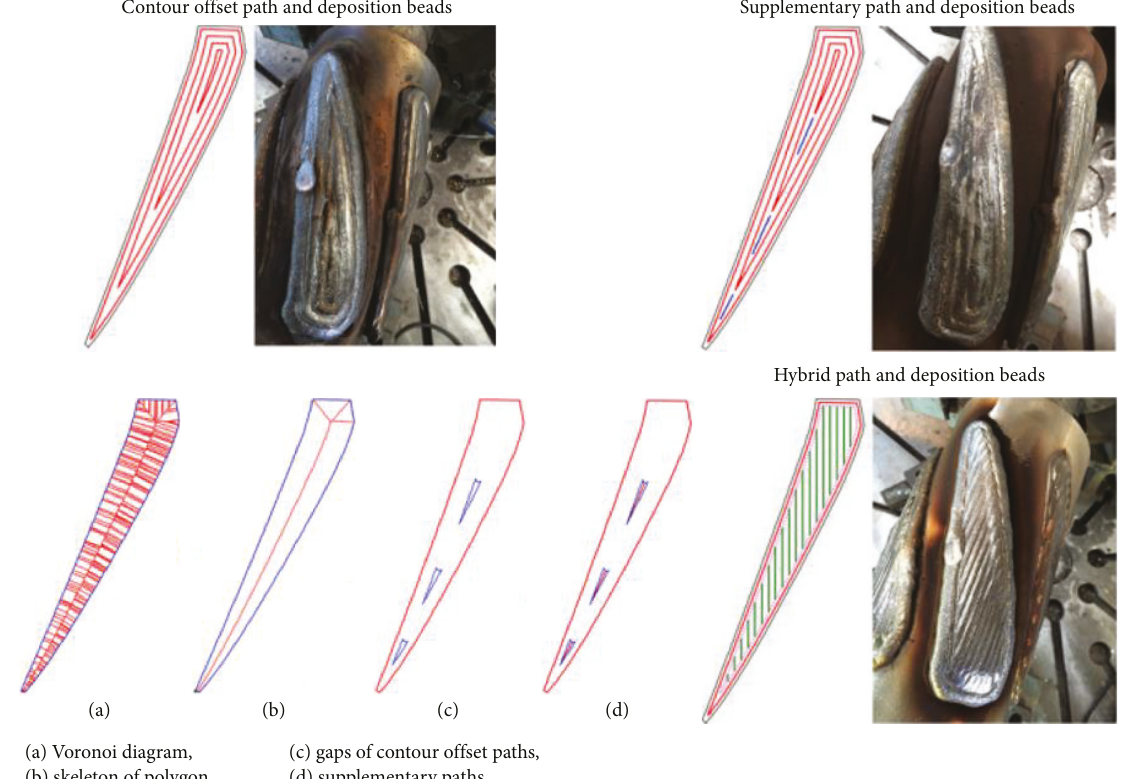
Figure 28: Different path planning